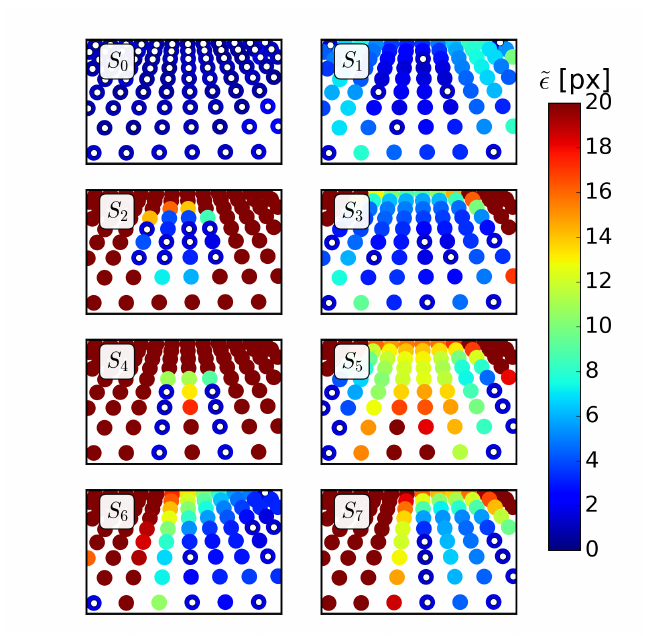
Figure 6. Errors ˜ (cid:101) for M 1 and angle A 1 at all the available points for the different sets S k . The GCPs for each set are here highlighted with white circles in the center and correspond to the points in Figure 4.